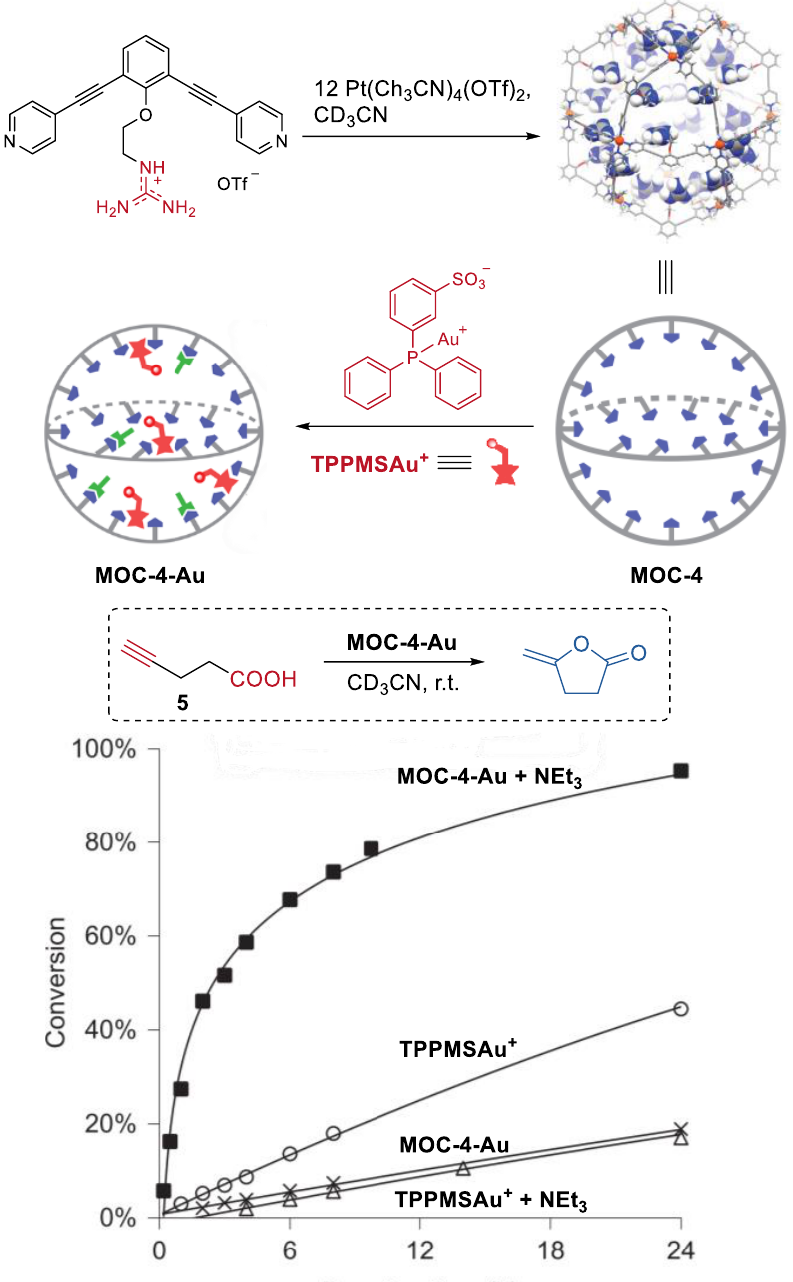
Figure 4. Cyclization reaction of acetylenic acid catalyzed by MOC-4 binding with Au(I) catalysts [51]. Reaction additions: 5 (10.0 mM), Au + (0.5 mM), MOC-4 (0.125 mM), NEt 3 (0.5 mM), CD 3 CN, r.t. Reprinted/adapted with permission from Ref. [51]. Copyright 2016 Springer Nature Ltd.